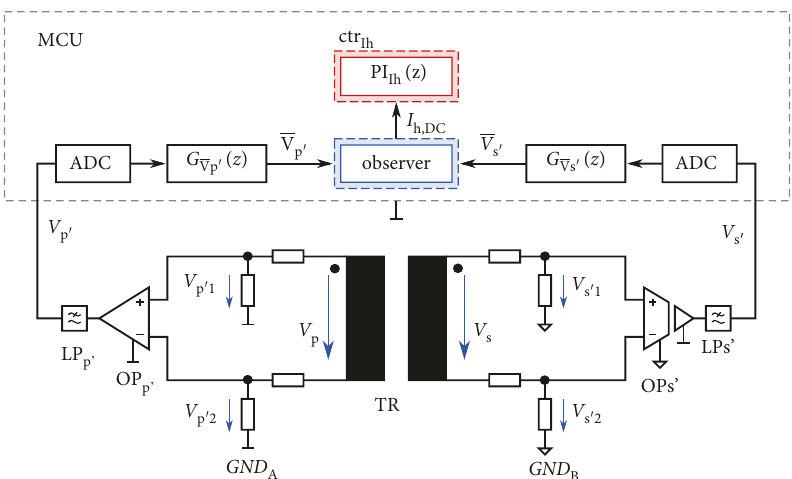
Figure 10: Measuring principle for in- and outputs of observer model. Voltage divider sets V perform differential measurement for V estimates I according to observer model for ctr Ih . h , DC